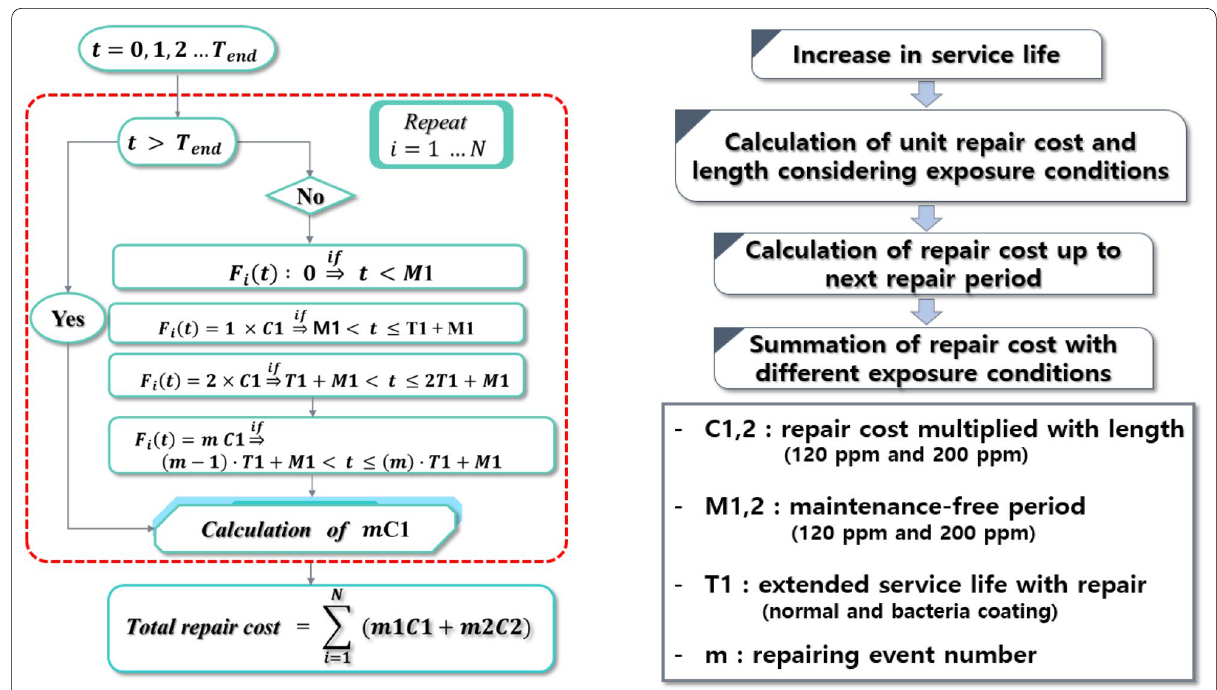
Fig. 8 Flowchart for repair event‑based total repair cost with deterministic method.